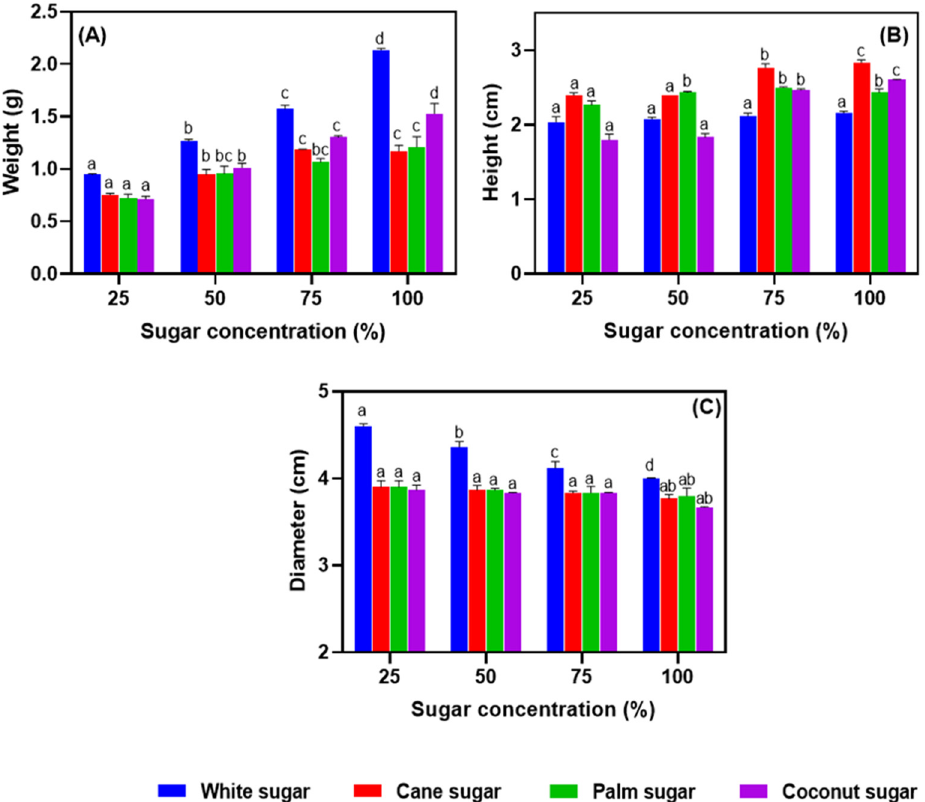
Figure 4. Weight ( A ), height ( B ), and diameter ( C ) of salted duck egg white meringues prepared with alternative types of sugar at various levels in the formulation. Different alphabets above the bars indicate significant differences among various conditions.